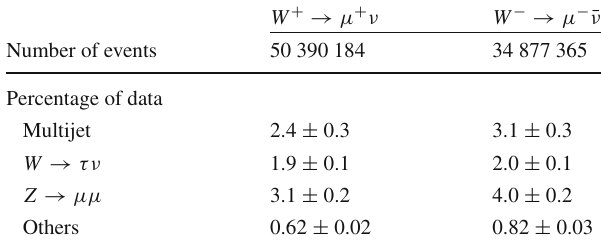
Table 1 The number of data events after event selection for W + → μ + ν and W − → μ − ¯ ν and the percentage of selected data that each of the three major backgrounds